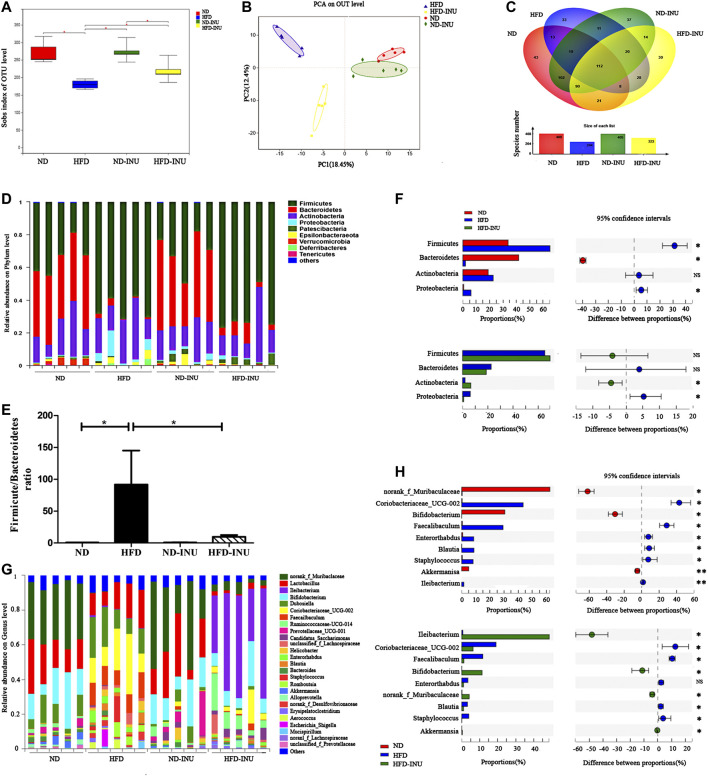
The alteration of gut microbial species from mice feces of diverse groups. (A) Sobs index showing difference in terms of abundance and diversity of gut microbiota in diverse groups. (B) Principal component analysis (PCA) analysis. (C) Venn diagram. (D,F) The relative abundance of microbial species in phylum level. (E) The ratio of Firmicutes to Bacteriodietes in phylum level. (G,H) The relative abundance of microbial species in genus level. NS: no significant difference. *p < 0.05, **p < 0.01. INU: inulin; ND: normal diet; HFD: high-fat diet.